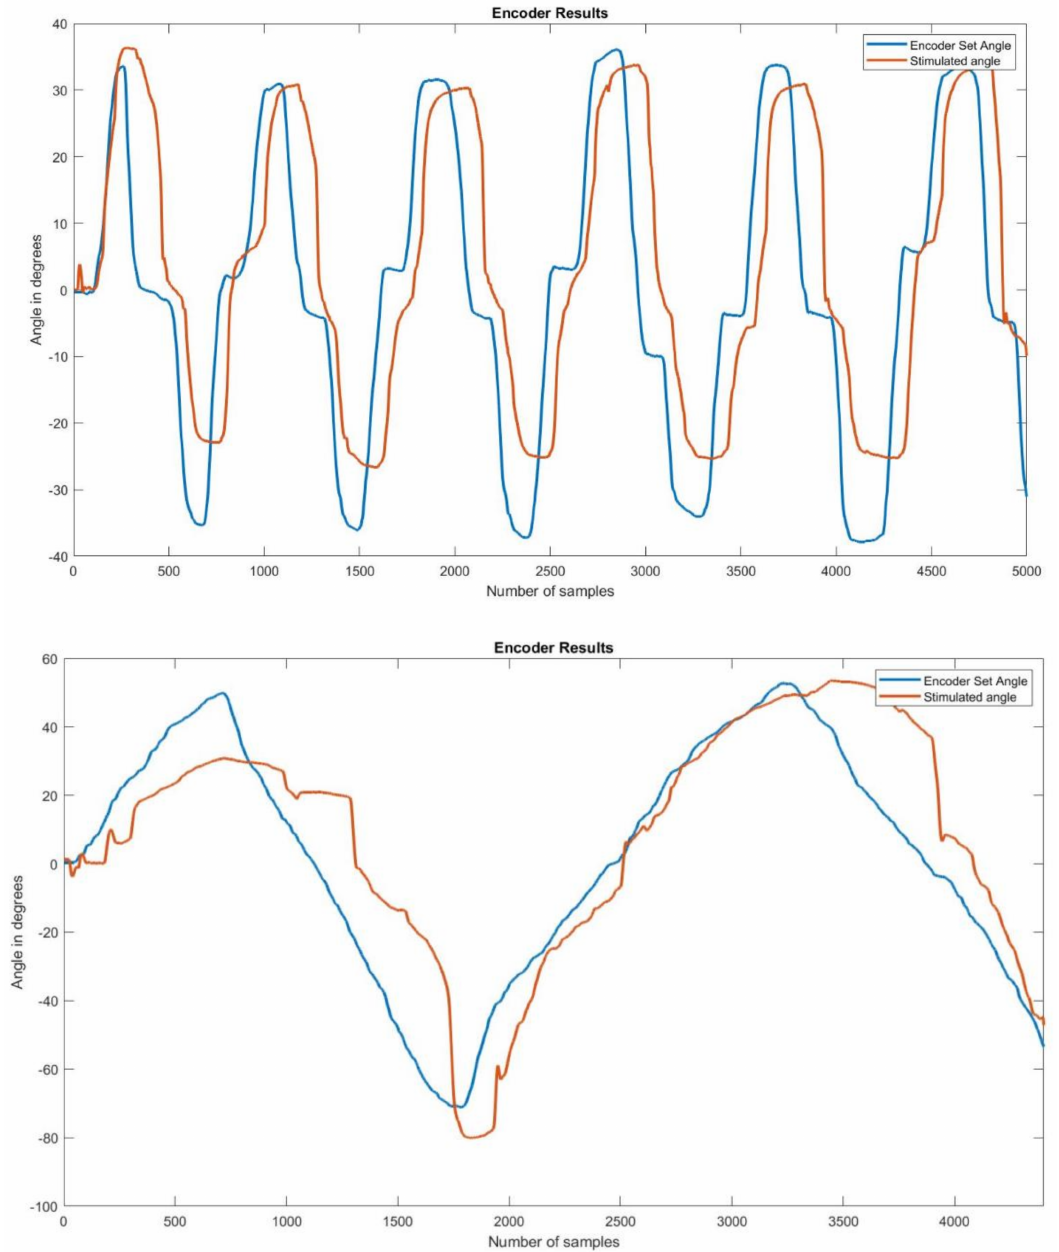
Figure 8. Encoder set and stimulated angle graphs on two participants. Each of the graphs above shows the stimulated angle overlapping the set angle, giving an idea as to how closely they followed each